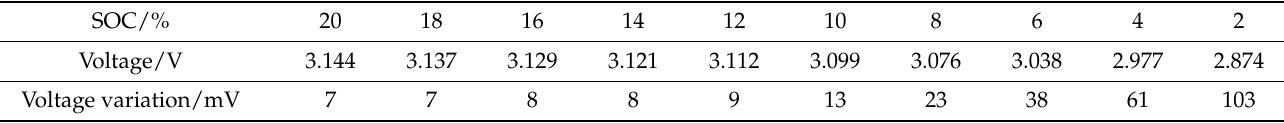
Figure 9. Voltage variation under constant current condition. Table 1. The terminal voltage of the battery when the SOC is 0–20%.